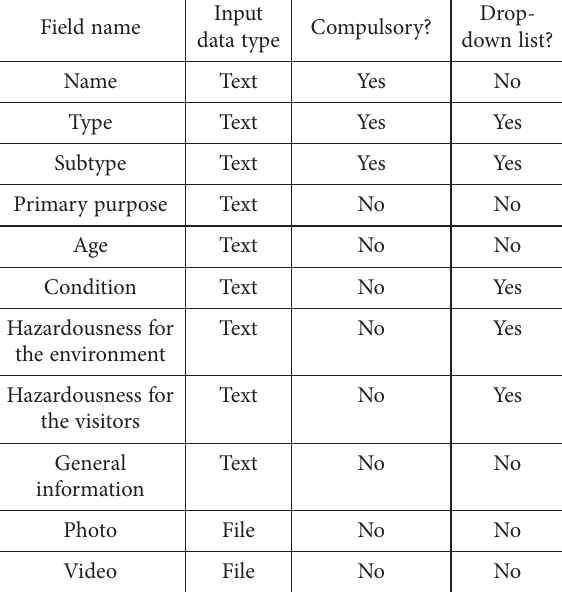
Table 1. Table of attribute